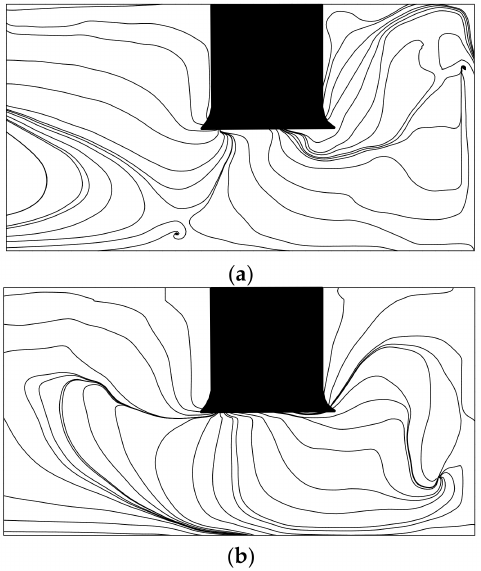
Figure 10. Streamlines on x – z plane under the condition of Q = 0.024 m 3 /s: ( a ) Case Q3A0 and ( b ) Case